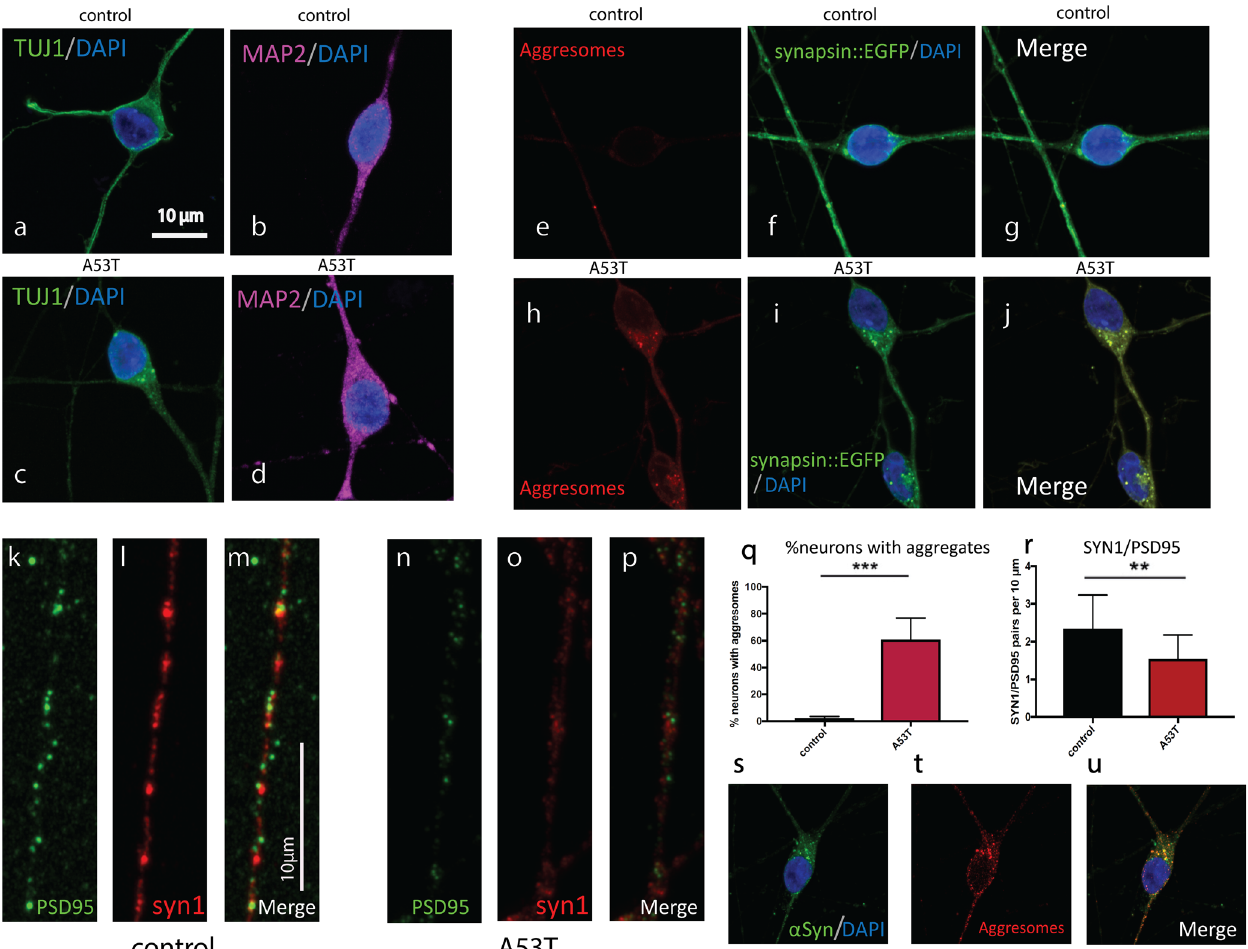
Fig. 6 Protein aggregates in A53T dopaminergic neurons. a Representative image showing expression of neuron-speci fi c class III beta- tubulin/ 4 ′ ,6-diamidino-2-phenylindole (TUJ1/DAPI) in control dopaminergic neurons. Scale bar 10 µm. b MAP2/DAPI expression in control dopaminergic neurons. Similar representative images of A53T dopaminergic neurons expressing TUJI/DAPI ( c ) and MAP2/DAPI d . e – g Control dopaminergic neurons exhibit almost no protein aggregates, as can be seen in the aggresomes and merged image with synapsin::EGFP/DAPI on the right. h – j A53T dopaminergic neurons display high levels of protein aggregates that is observed in the aggresomes staining. k – p Immunostaining for postsynaptic density protein 95 (PSD95 in green) and synapsin1 (syn1) reveals a drastic decrease in the ratio of synapsin1 to PSD95, indicating fewer synapses. q Quanti fi cation of protein aggregates shows a drastic increase in the number of neurons harboring protein aggregates in the A53T mutated neurons compared to controls. r Quanti fi cation of the ratio of syn1/PSD95 shows a drastic and signi fi cant decrease in A53T dopaminergic neurons compared to controls. s – u α -Synuclein staining and aggresomes reveal co-localization of some of the protein aggregated with α -synuclein. Error bars represent standard deviations in this fi